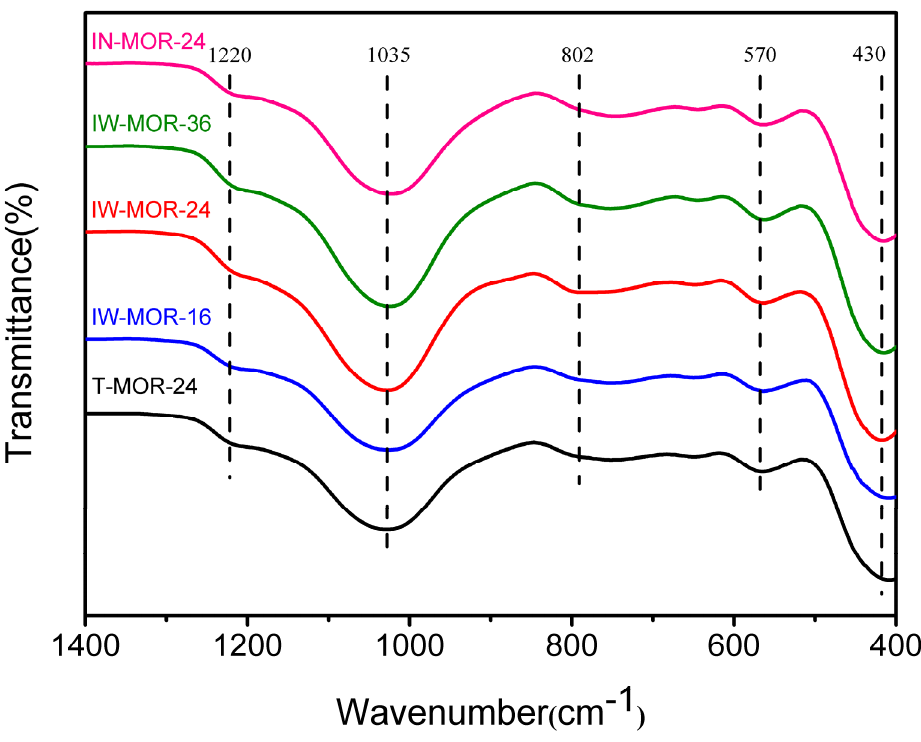
Figure 6. FT–IR profiles of T–MOR–24, IW–MOR–16, IW–MOR–24, IW–MOR–36 and IN–MOR–24 samples.